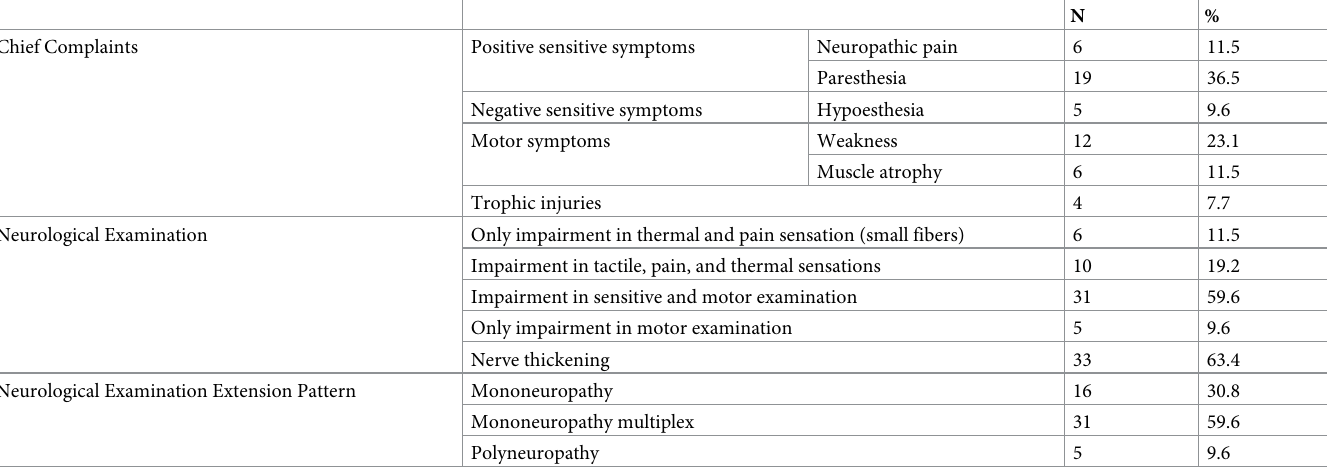
Table 1. Chief complaints and neurological examination at the diagnosis.